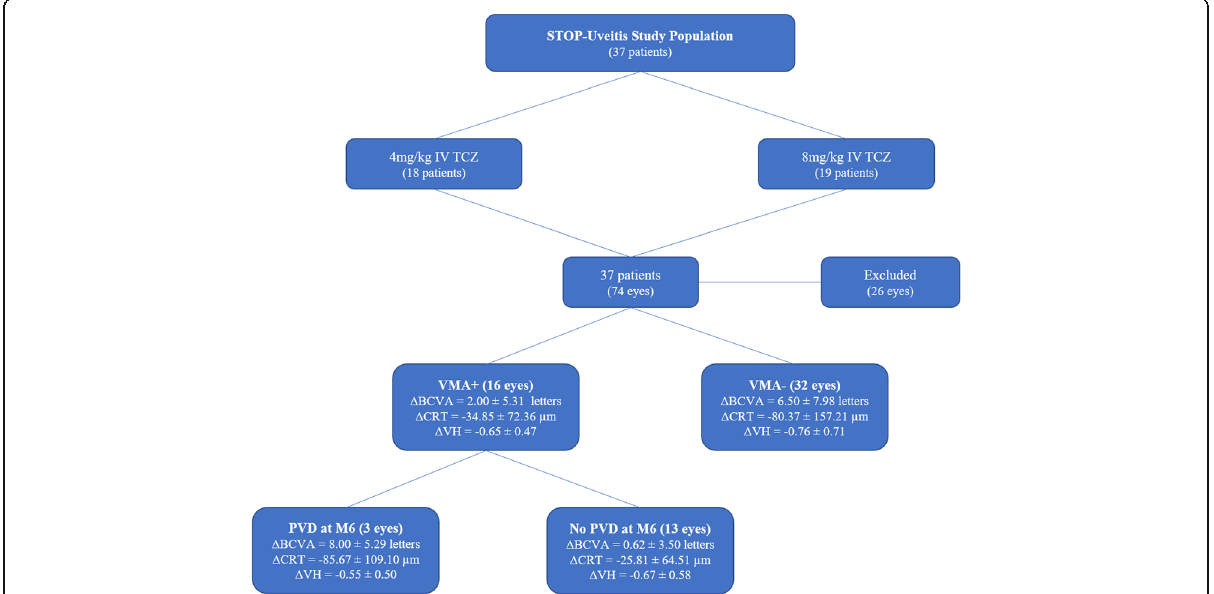
Fig. 4 Study population. Flowchart outlining the characteristics of the study population. BCVA, best-corrected visual acuity; CRT, central retinal thickness; IV, intravenous; TCZ, tocilizumab; VH, vitreous haze; VMA+, vitreomacular adhesion present; VMA − , vitreomacular adhesion absent; Δ , mean change from baseline to month